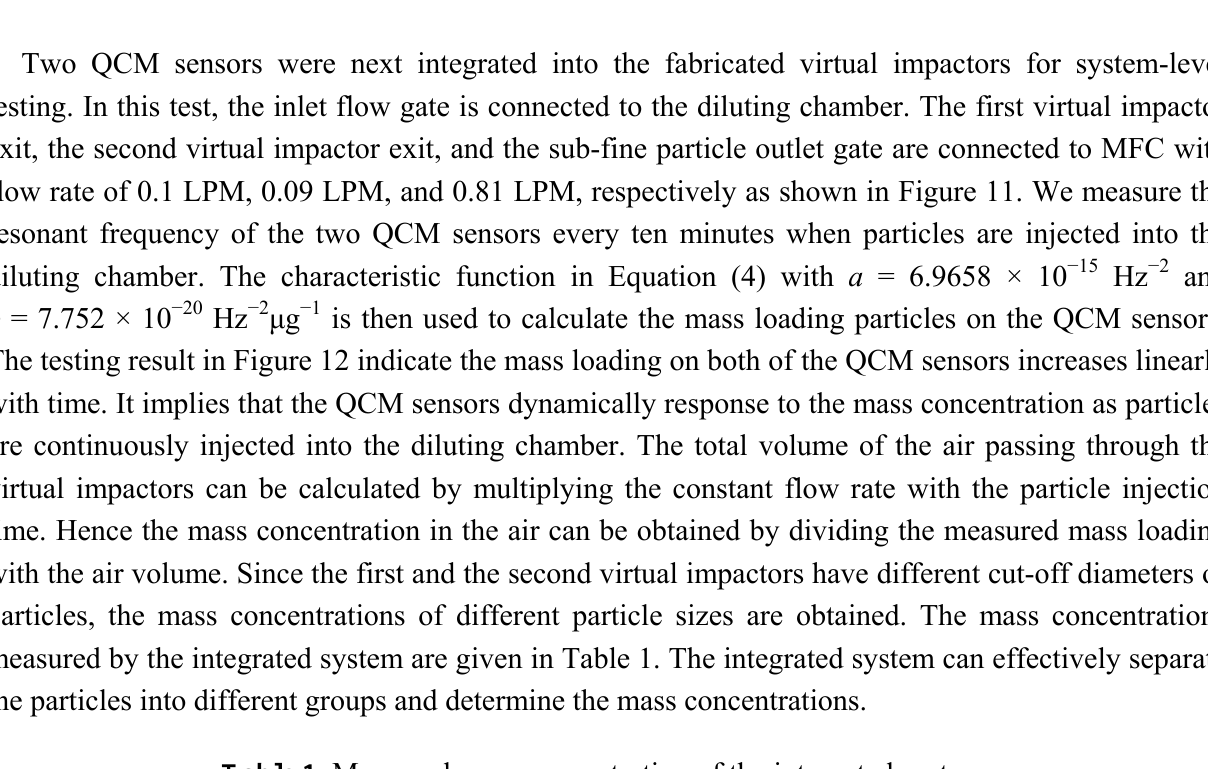
Table 1. Measured mass concentration of the integrated system.